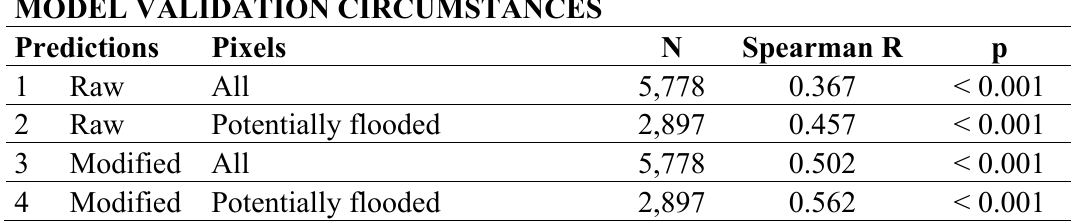
Table 2. Model validation with Spearman correlation between the observed fraction of water cover in a given pixel and the ratio predicted by the model. The number of pixels used for the correlation (N), the test statistic (Spearman R) and p-value are shown. The model was validated under four different circumstances: (1) Model predictions of all pixels; (2) Only pixels in potentially flooded areas could be flooded and those outside were assumed dry; (3) All pixels were considered but model predictions below 0.21 were considered as dry pixels and (4) Only pixels in potentially flooded areas with predictions equal and above 0.21 were flooded.